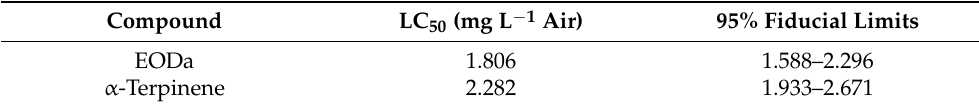
Table 1. Fumigant toxicity of the Dysphania ambrosioides essential oil and α -terpinene against D. melanogaster adult flies.